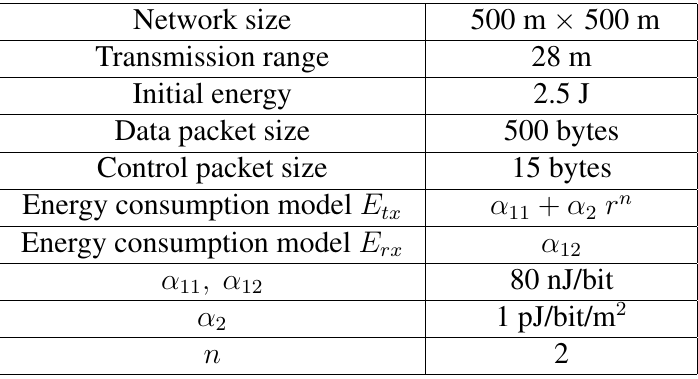
Table 2. Simulation